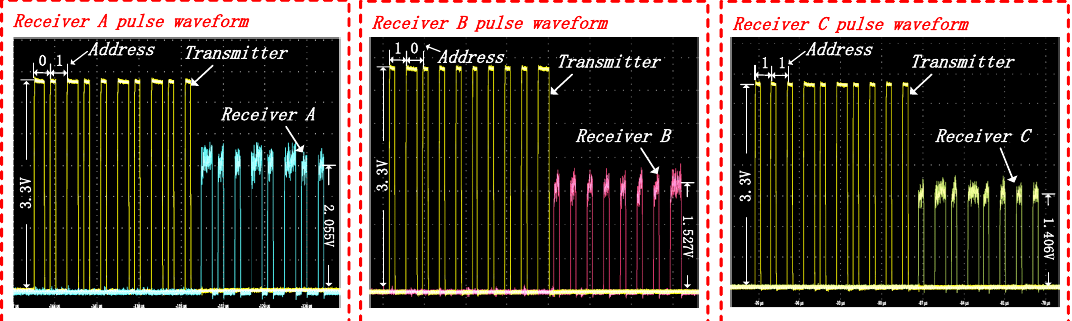
Figure 13. Waveform diagram of receiving terminal for changing receiving angle.